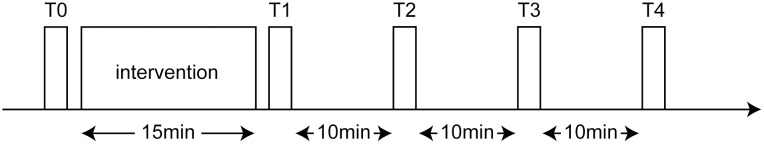
The experimental sequence used in the present study.